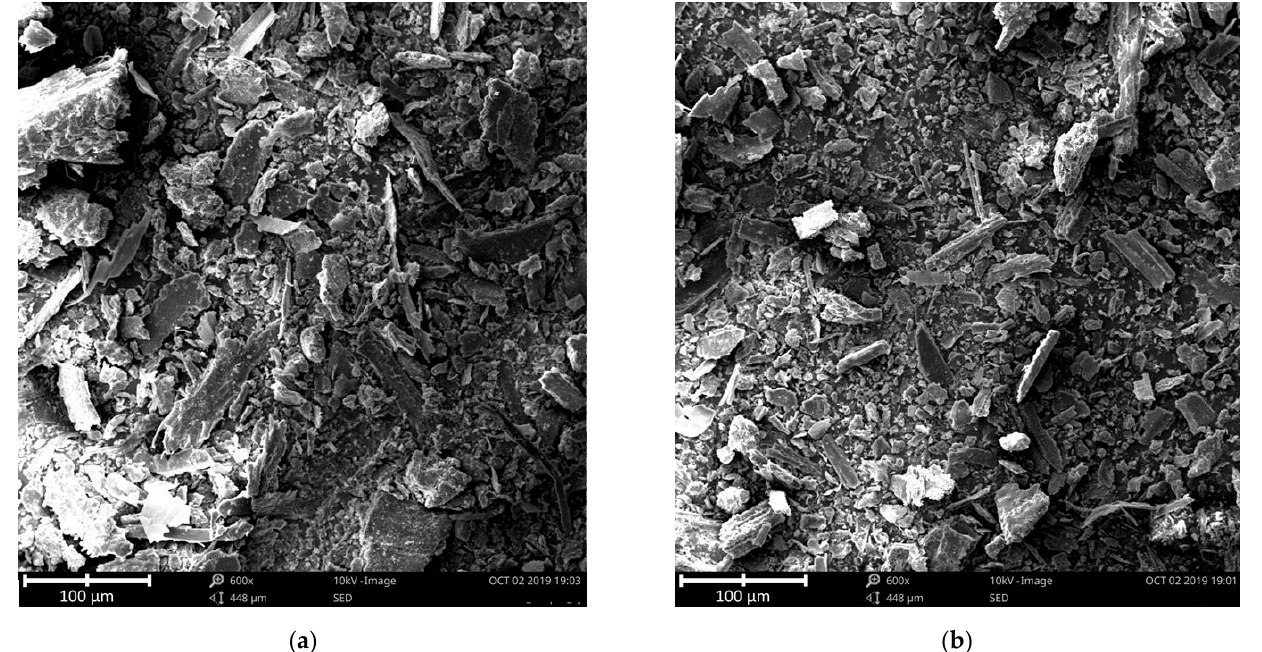
Figure 3. SEM images in 600× magnification of: ( a ) milled Type-1 straw dust; ( b ) milled Type-2 straw dust.